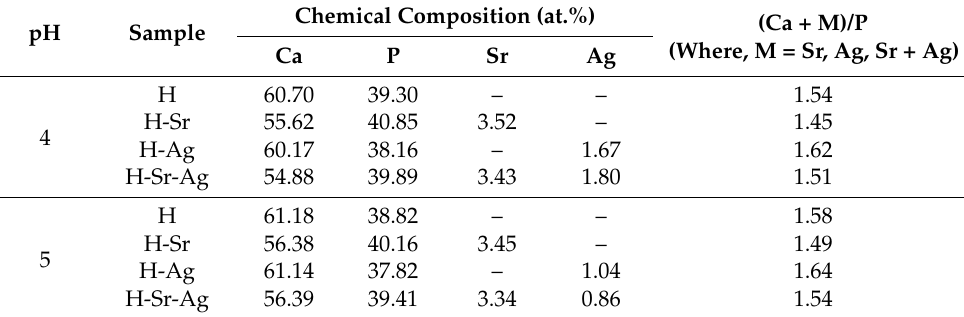
Table 2. Chemical composition of the coatings at different pH